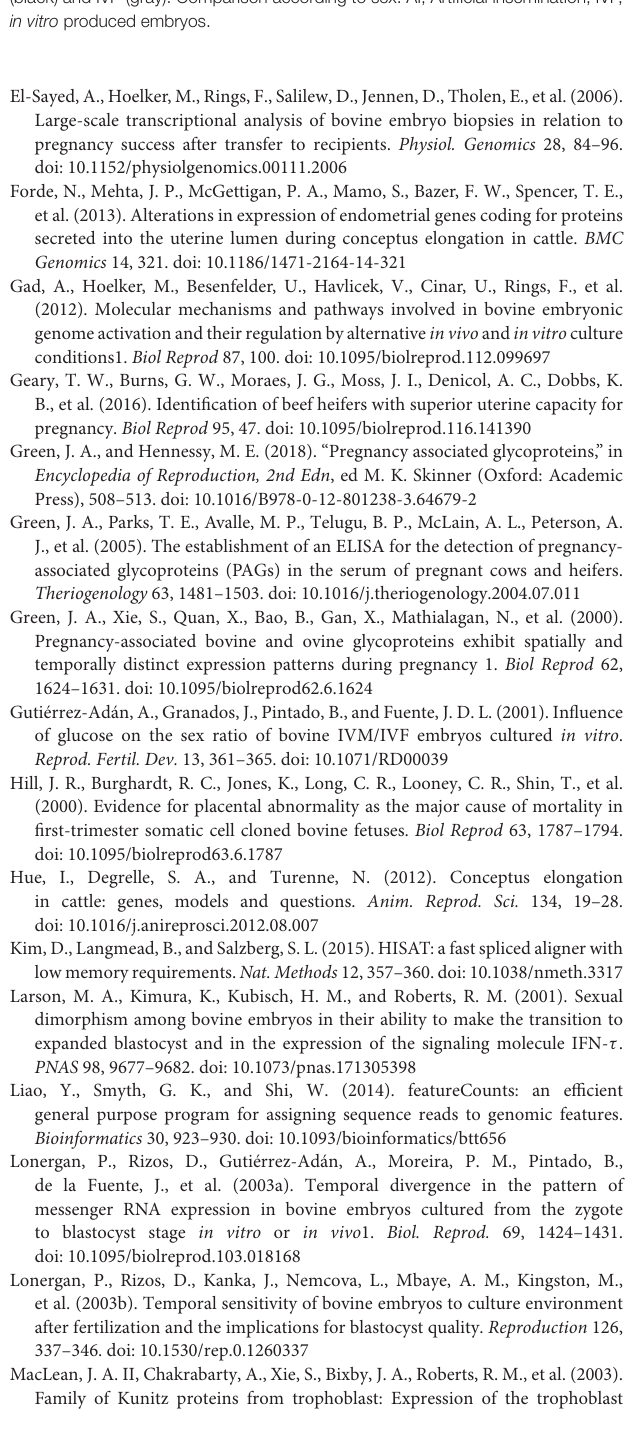
Supplementary Figure 1 | The overall number of differentially expressed genes (DEGs) obtained from the RNA-sequencing analysis. Numbers of DEGs in the AI (black) and IVP (gray). Comparison according to sex. AI, Artificial insemination; IVP, in vitro produced